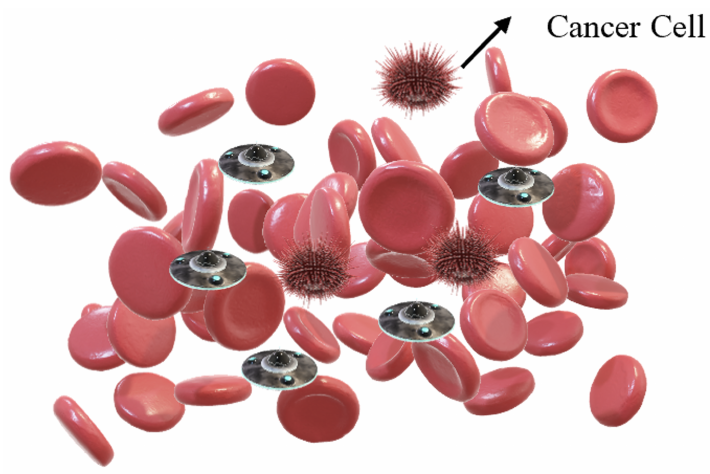
Figure 8. Nanorobots for selective destruction of cancer